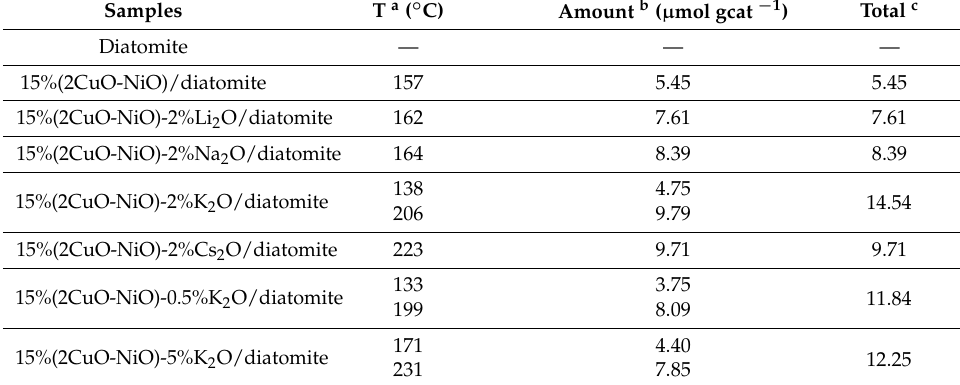
Table 2. Quantification of the NH 3 -TPD profiles of as-prepared catalysts.